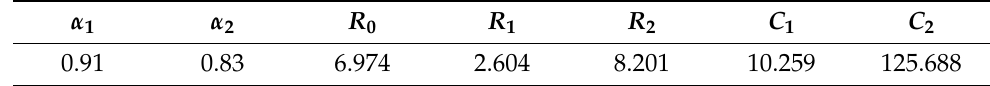
Table 1. Identification results of the